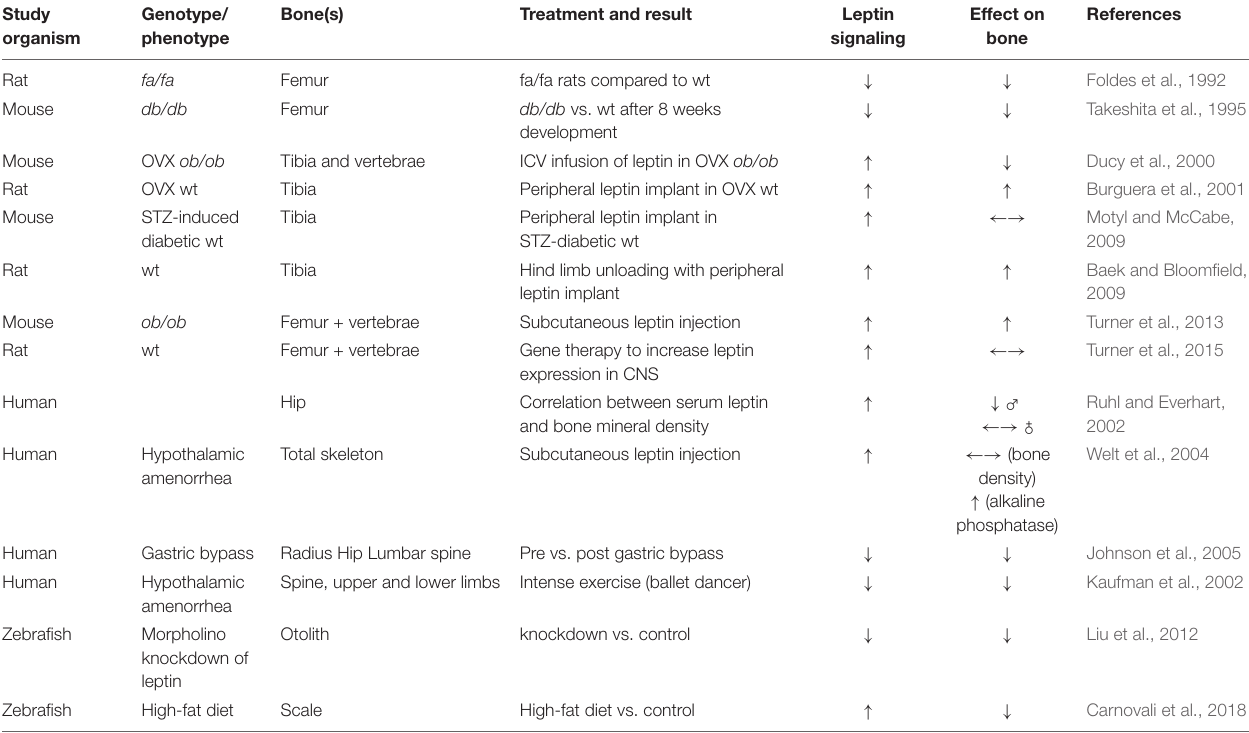
The table is a generalized overview tabulating the diversity of reported responses of bone to leptin. For each study, how the variable(s) changed leptin signaling (increase ↑ , decrease ↓ ), and the reported response of bones (increase ↑ , decrease ↓ , or no change ←→ ) is listed. For example, fa/fa rats do not express functional leptin receptors; thus, leptin signaling is reduced compared with wild-type controls, and the reported response is a decrease in bone mass (Foldes et al., 1992). This table is a greatly simplified representation of the reported results; many more variables were tested in the studies than are represented. Similarly, how each study measured the response of bone is diverse (including bone volume, bone mineral density, bone area, enzyme activity, etc.) and is not intended to be equivalent across studies. fa/fa, leptin-receptor deficient rat; db/db, leptin-receptor deficient mouse; ob/ob, leptin-deficient mouse; wt, wild-type; OVX, ovaries removed; STZ, streptozotocin antibiotic (used to induce